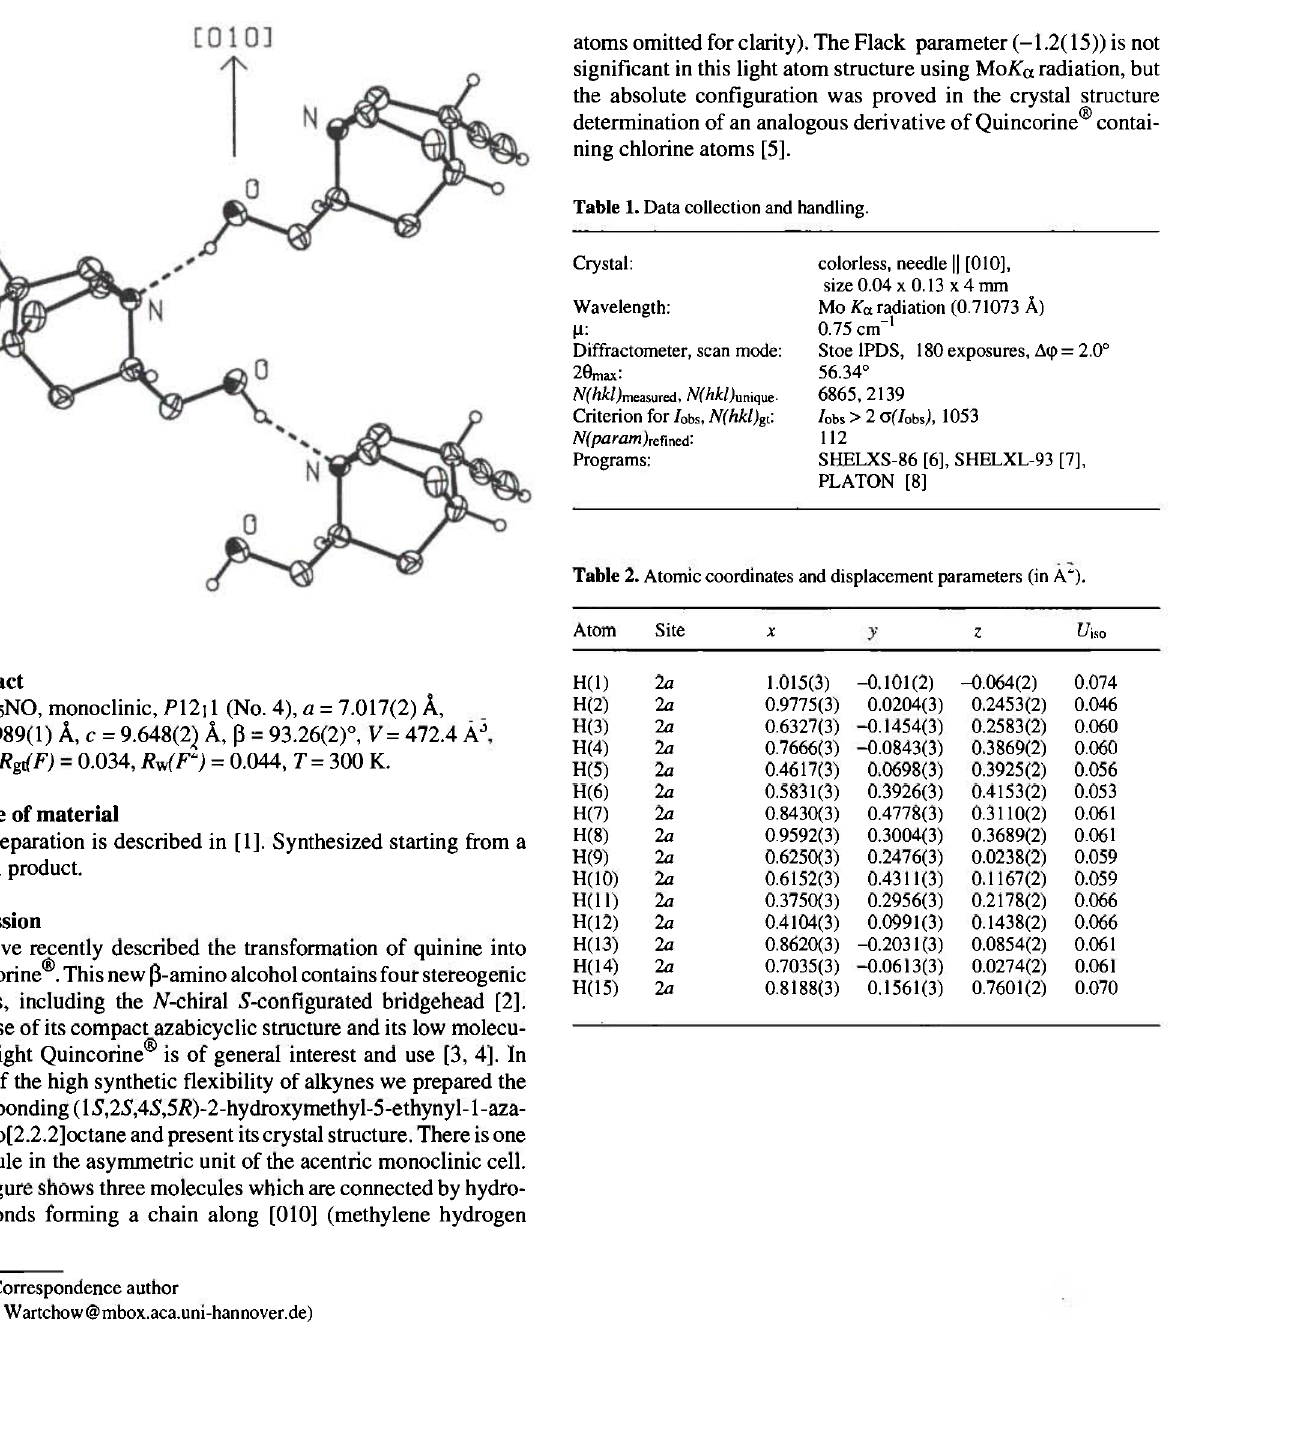
Table 1. Data collection and handling.